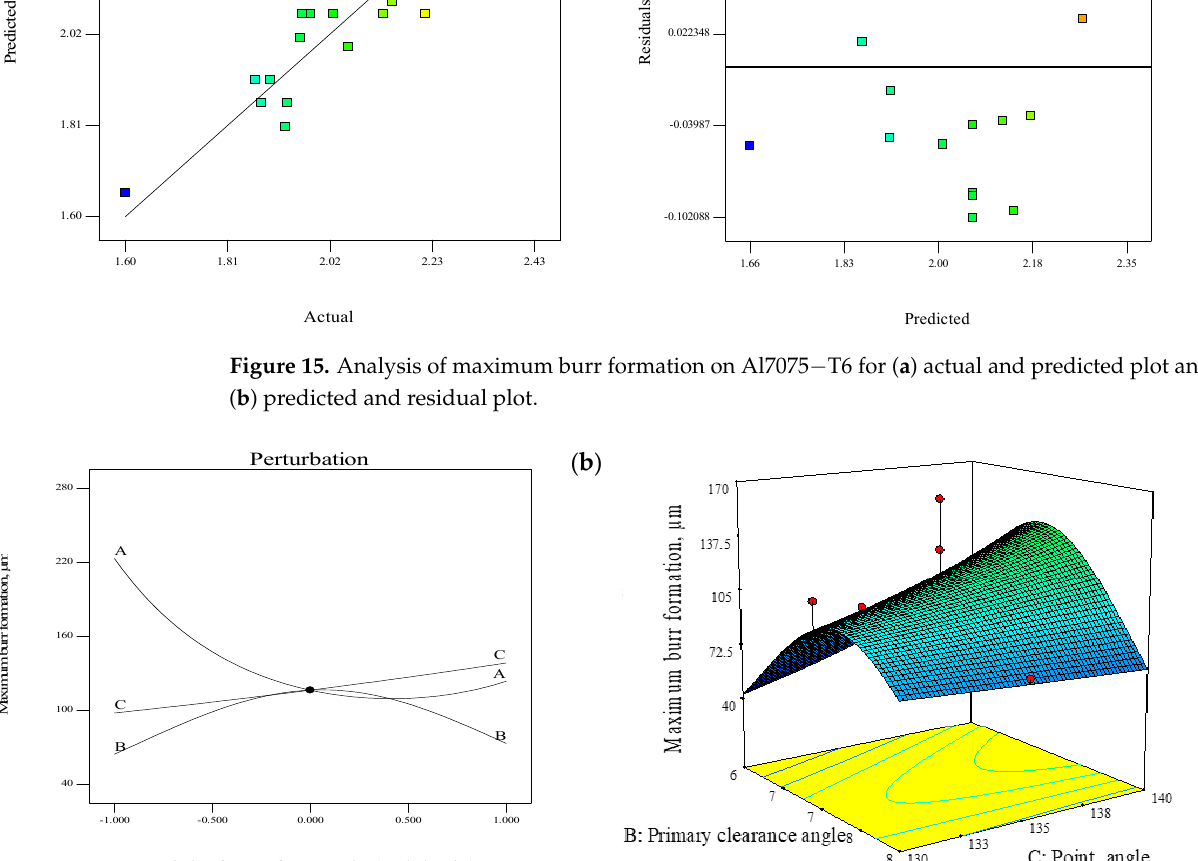
Table 6. Goals and constraints for the factors and responses.